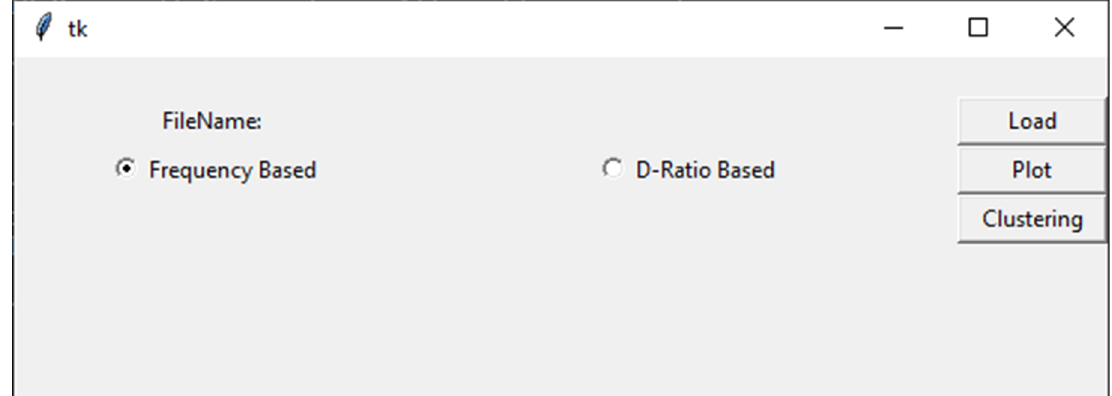
Figure 1. Overview of the VIRMOTIF main page.